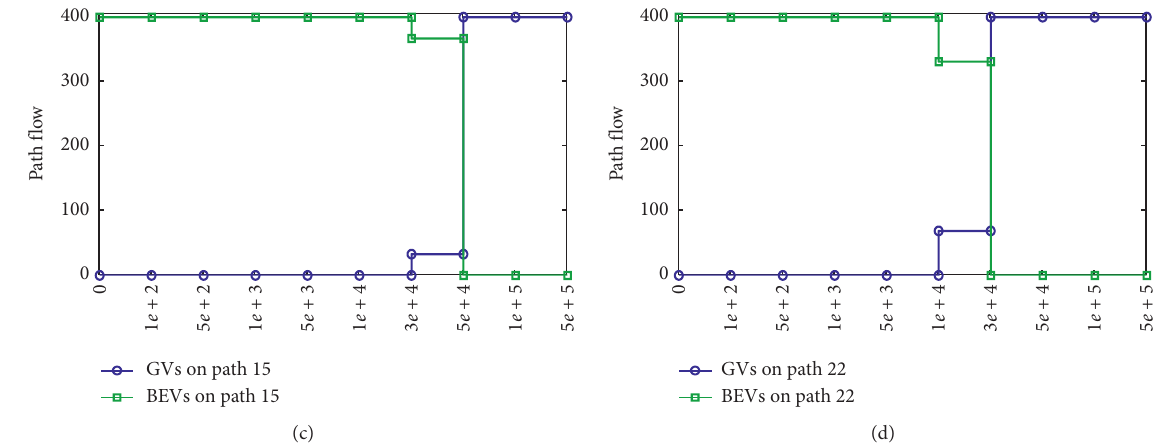
Figure 8: Changing total credits of GVs in Nguyen–Dupuis’ network. (a) O-D pair (1, 2). (b) O-D pair (1, 3). (c) O-D pair (4, 2). (d) O-D pair (4,